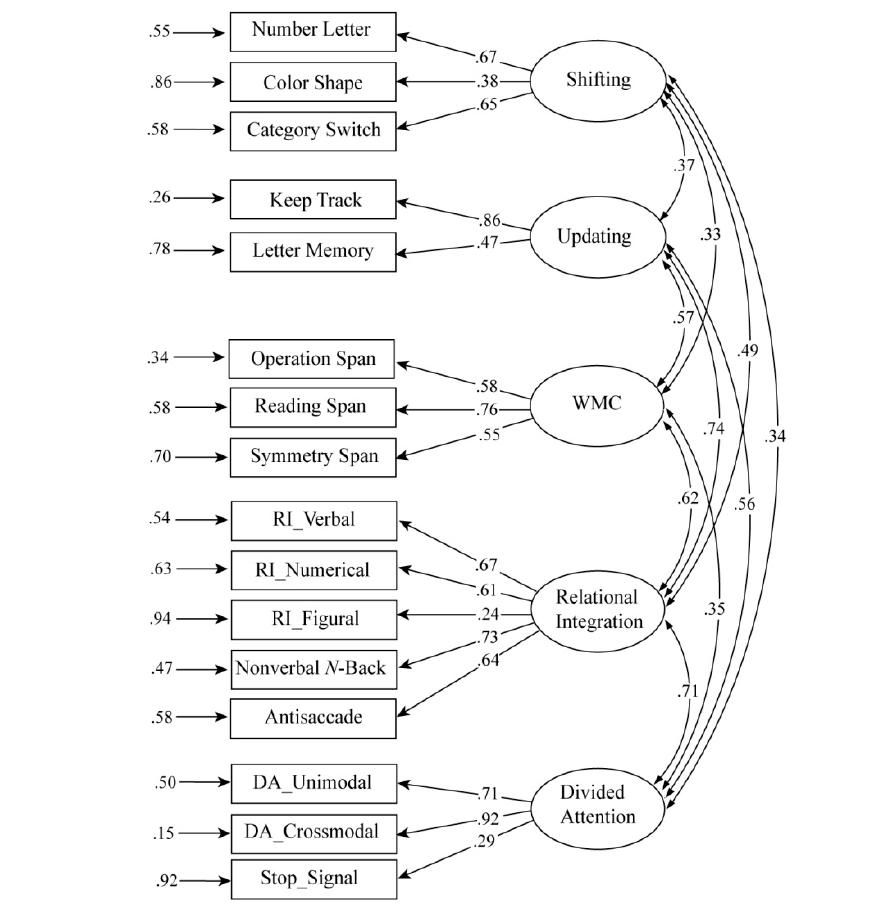
Figure 1. Correlated cognitive latent variables models. The proportion of residual variance of each indicator was calculated by subtracting the variance of the indicator from 1. All parameters were statistically significant ( p < .05). WMC = working memory capacity; RI = relational integration; DA = divided attention.